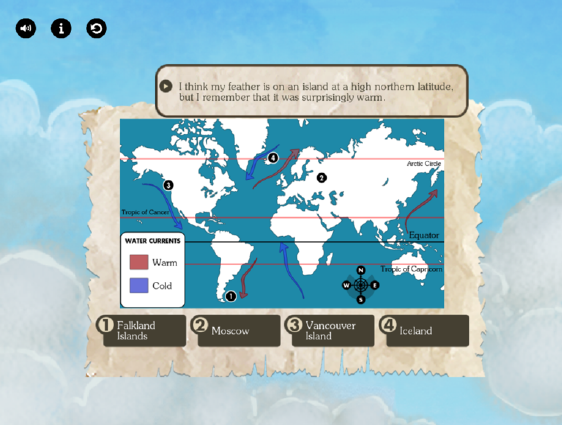
Figure 3. Questions to complete for entry into region. pending on the elevation and temperature of the region; the water droplet becomes a vapor cloud at high alti- tudes or a piece of ice in colder climates (see Figure